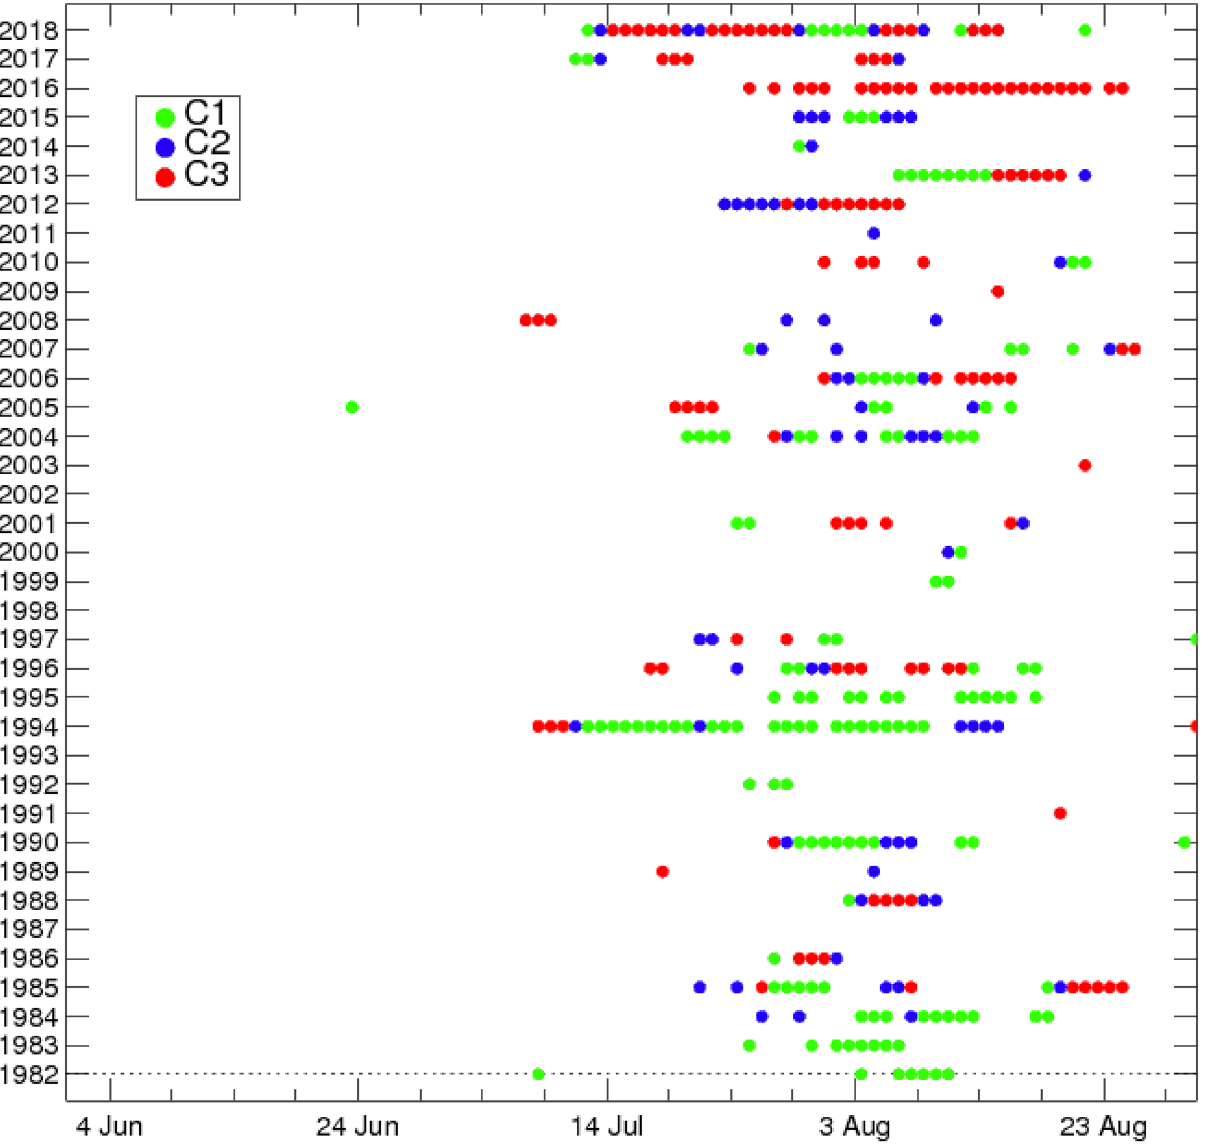
Figure 3. Daily temporal distributions of the three SOM cluster patterns.